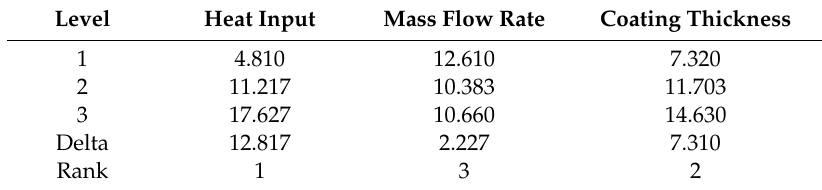
Table 9. Table of responses for means.